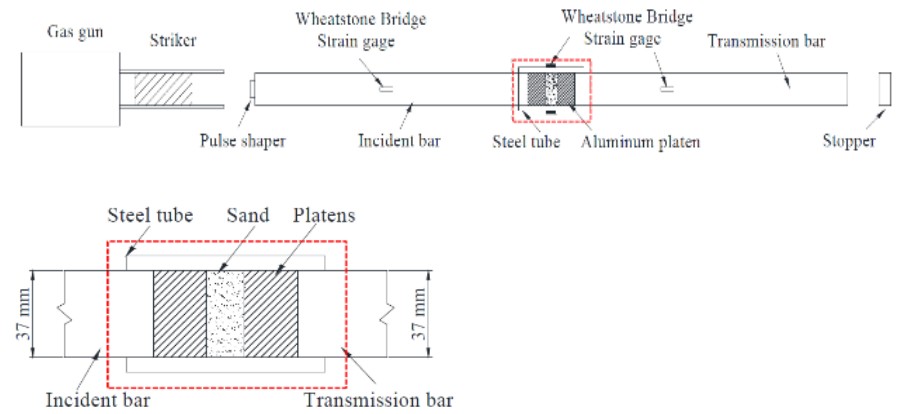
Figure 11. Schematic view of SHPB test with a soil specimen (reprinted from Ref. [76]). (VI) Test Soil Material: Calcareous and silica